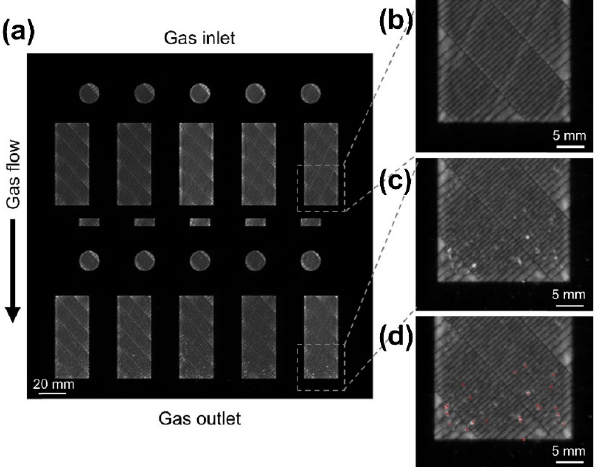
Figure 15. The results obtained by the monitoring system in conjunction with the spatter detection algorithm. ( a ) Sample long-exposure image consisting of the signals emitted during the exposure of a single layer on the entire build area. ( b ) A sample area near the gas inlet without any identified disturbances is highlighted for comparison. ( c ) Areas with disturbances are observed preferentially near the gas outlet. ( d ) A sample output from the spatter detection algorithm, in which the region shown in ( c ) is overlayed with detections. (Reprinted with permission from Ref. [82]. Copyright 2021 Elsevier B.V.).